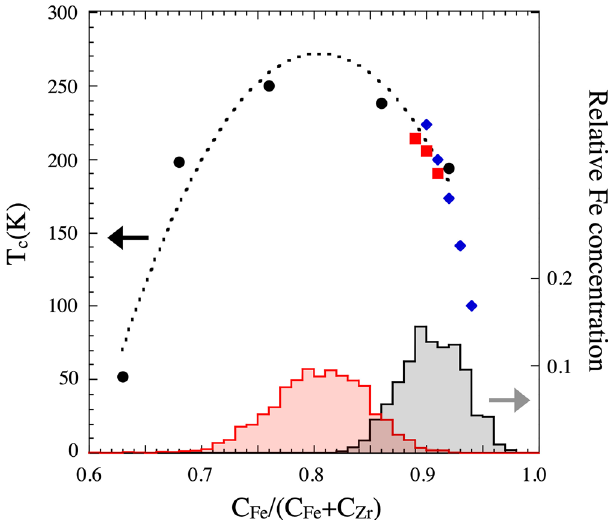
Fig. 3. Illustration of the changes in T c (left y-axis) with Fe concentration and the local abundance of Fe in the samples (right y-axis). The black circles (fitted) are from Sharma et al. 25 , the blue diamonds are from Read et al. 26 and the red squares are from Korelis et al. 27 . The shaded area shows the relative abundance of the local Fe concentrations in both the samples (the areas are normalized to unity). Average Fe concentrations of (cid:31) 0.93 results in crystallisation of the